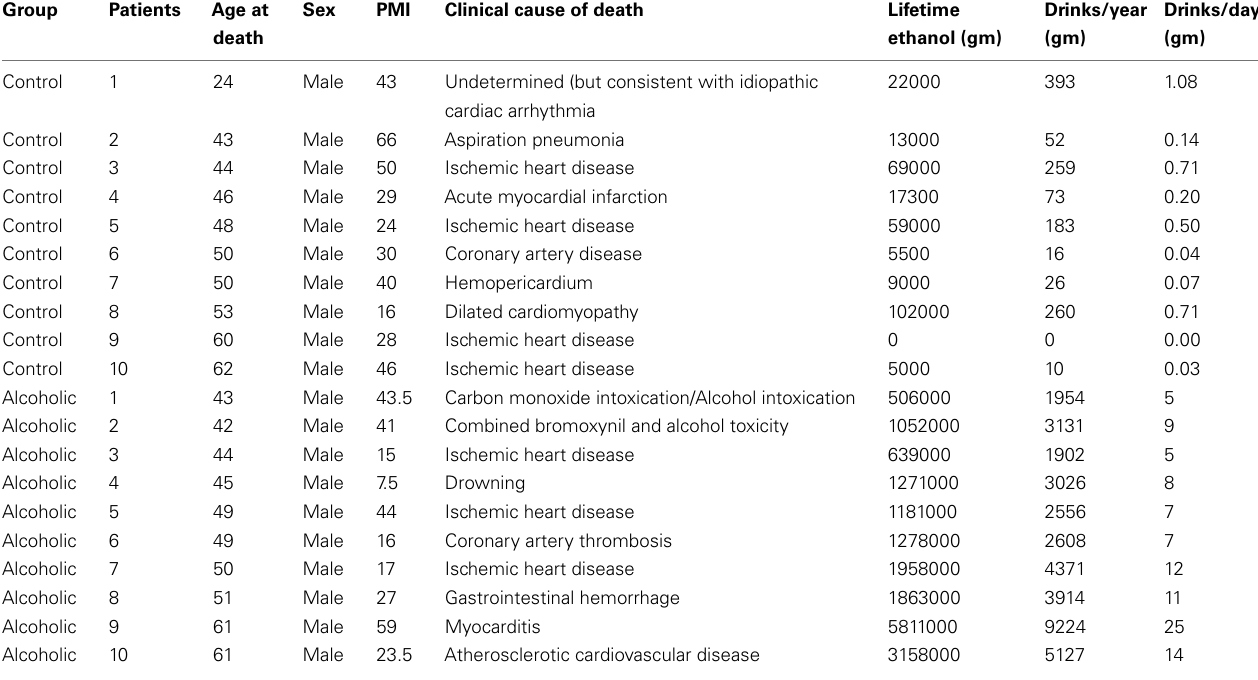
Table 2 | Clinical data of patients with controls and alcoholics.